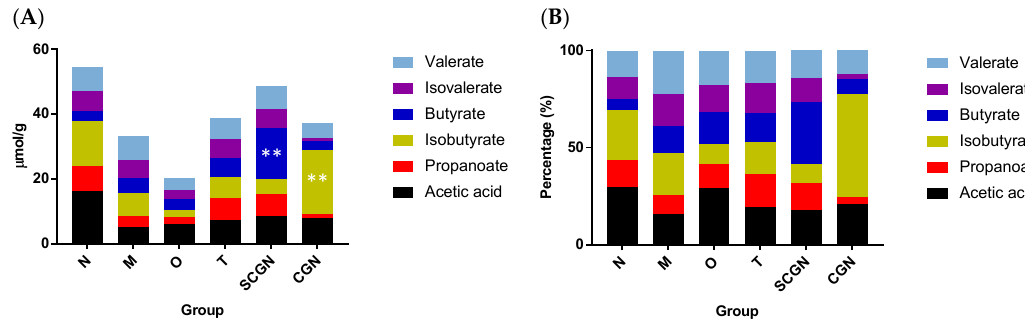
Figure 5. Protein levels of selected genes with significant changes in mRNA expressions: ( A ) fatty acid synthase (FASN), ( B ) AdipoR2, and ( C ) ACO hepatic levels. Values are given as mean ± SEM, n = 5. Statistical significances were calculated using two-way ANOVA with Dunnett post-test (* p < 0.05, ** p < 0.01); # denotes versus N, * denotes versus M.